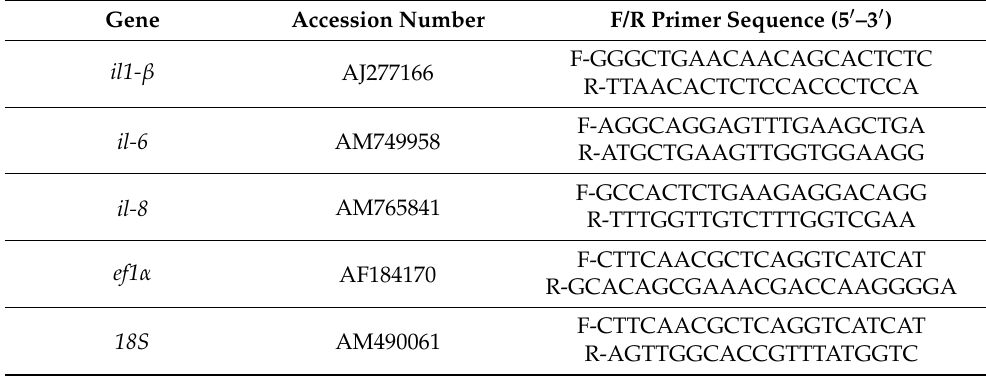
Table 2. Gilthead seabream primer sequences utilized for the real-time PCR.